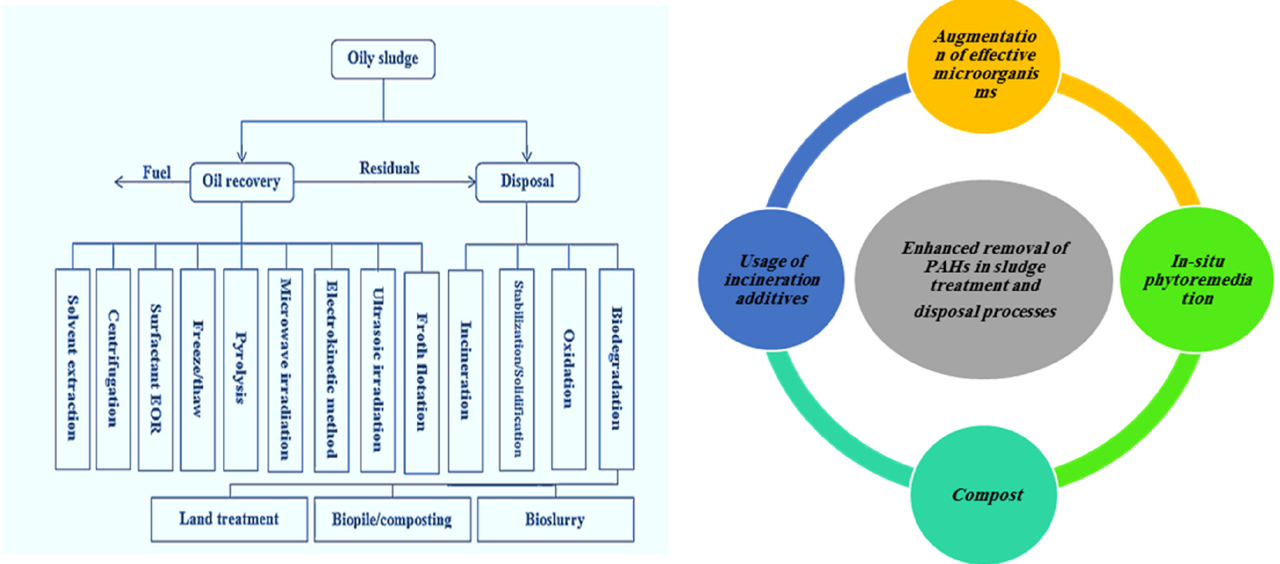
Figure 8. Overview of oily sludge treatment methods (License Number: 5435450889910) [105].